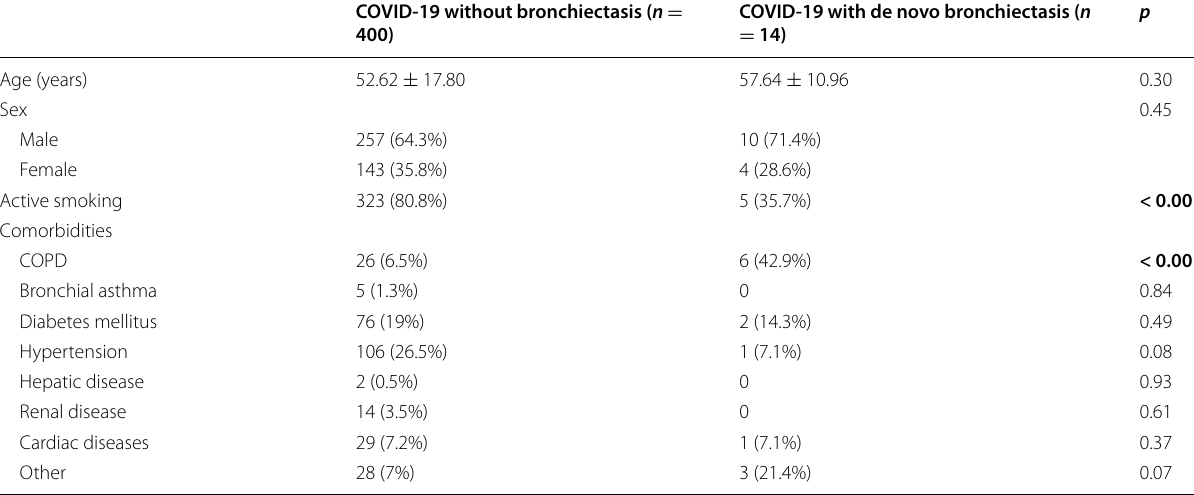
Data expressed as frequency (percentage), mean (SD). P value was significant if < 0.05 COPD chronic obstructive pulmonary disease, COVID-19 coronavirus disease 2019 Age was compared by Mann-Whitney test and all nominal data was compared by chi 2 test